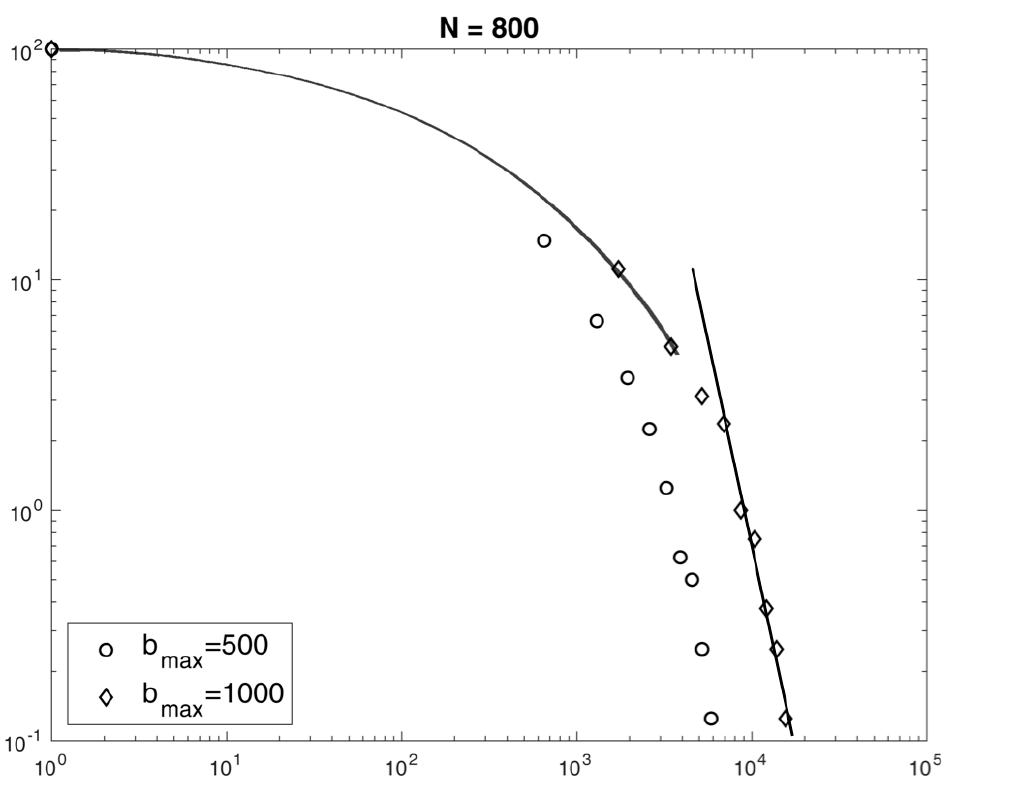
Figure 7. Log-log plot of cumulative percentage of population (800 nodes) according to the level of wealth after the sequence of transactions in the cases b max = 500,1000.